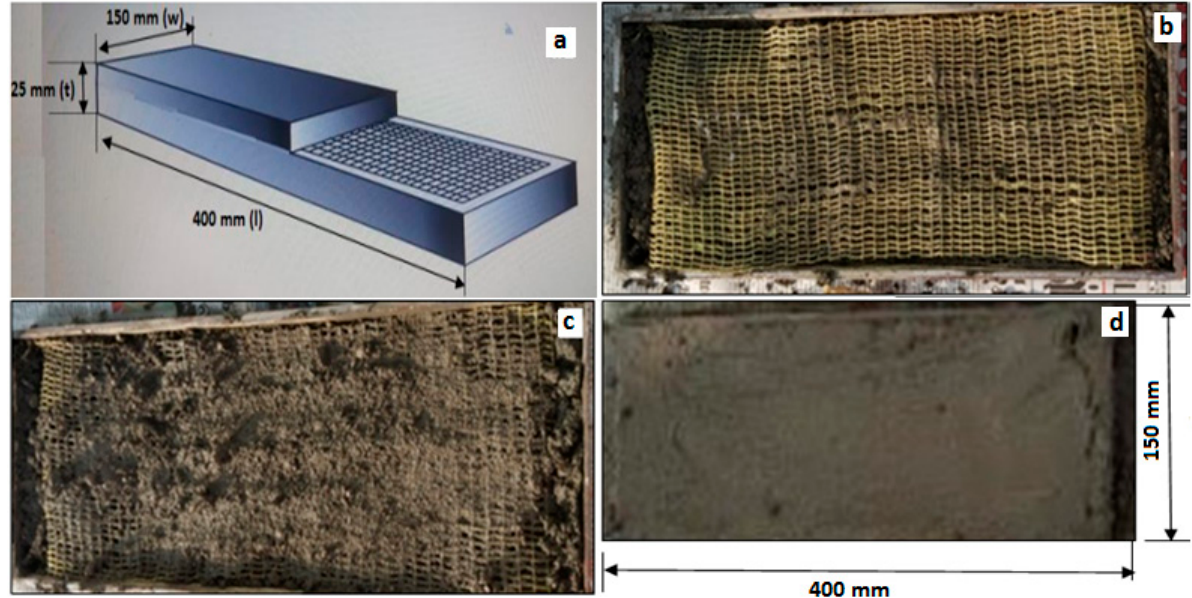
Figure 4. ( a ) Warp knitted fabric with scalebar, ( b ) Warp knitted fabric in mould, ( c ) composite preparation, and ( d ) ferrocement composite casting process.